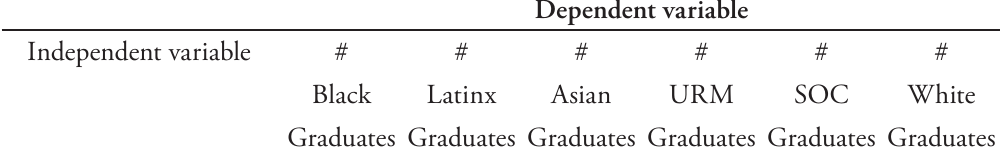
Table 4. Unstandardized Coefficients for Random Effects Analyses